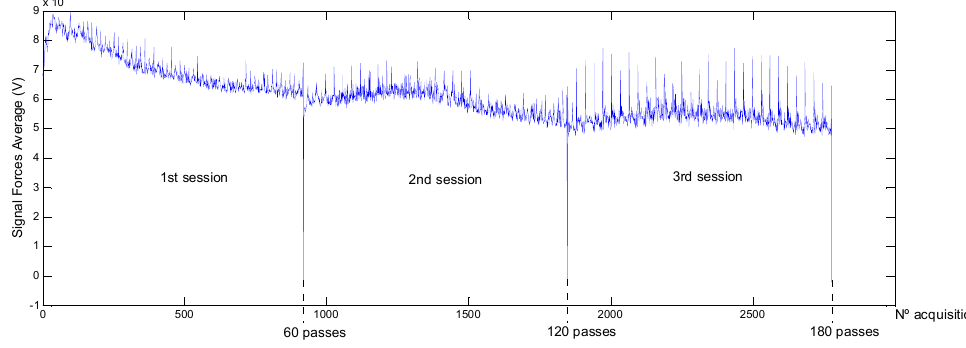
Figure 3. Signal forces average ( F average ) during the three polishing sessions.